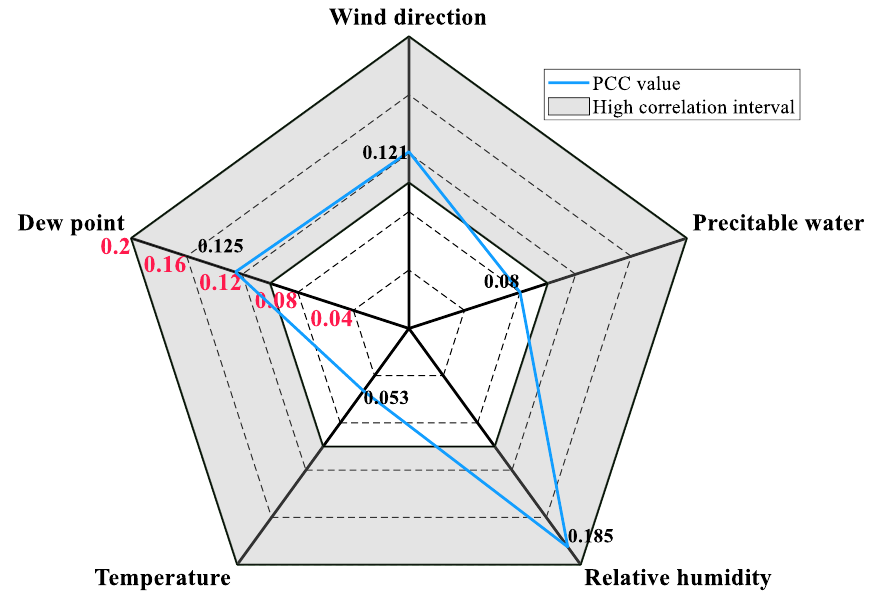
Figure 5. Schematic diagram of feature selection results.